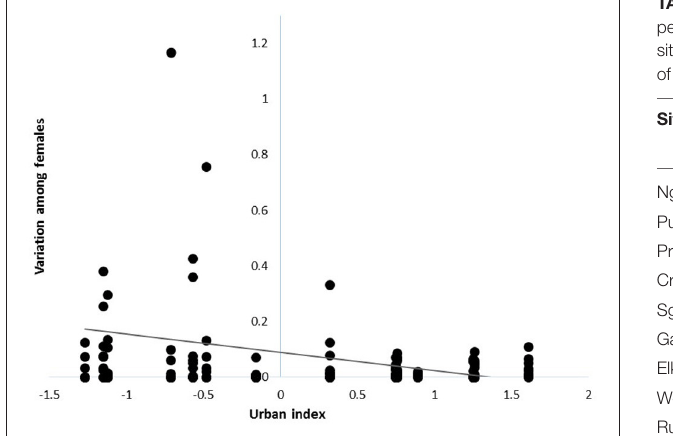
FIGURE 1 | Variance in reproductive contributions of female cardinals breeding across a rural-to-urban landscape gradient in Ohio, USA from 2004 - 2014. Each point reflects the variation among females breeding within a given site and year (i.e., sum of squared reproductive contributions).